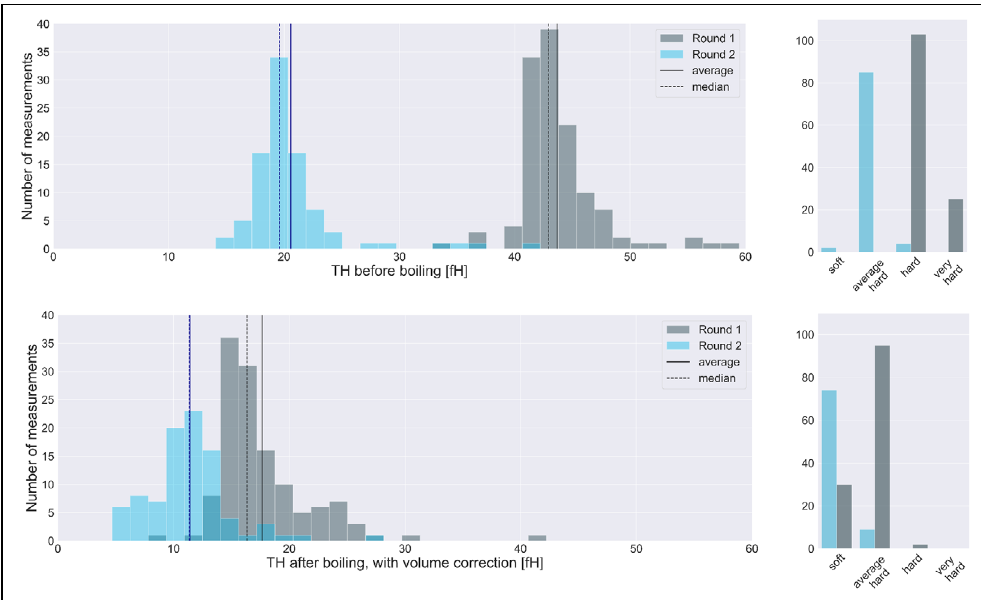
Figure 3 Total hardness (TH) measurements before and after the boiling